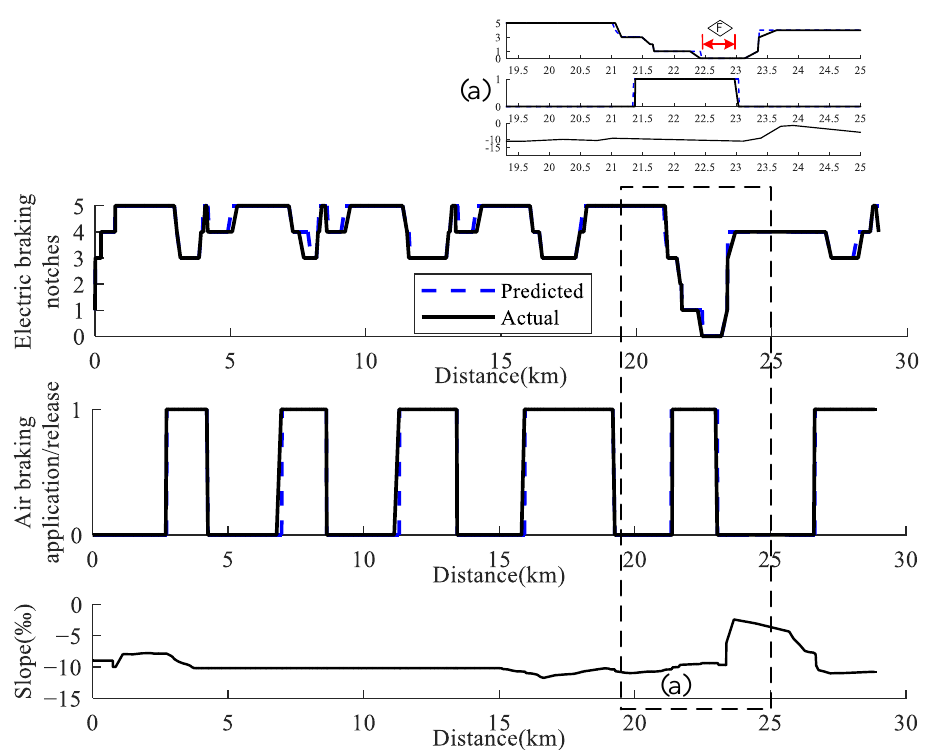
Figure 8. Scenario 1: comparison of predicted and actual control strategy. ( a ) Section from 19.3 km to